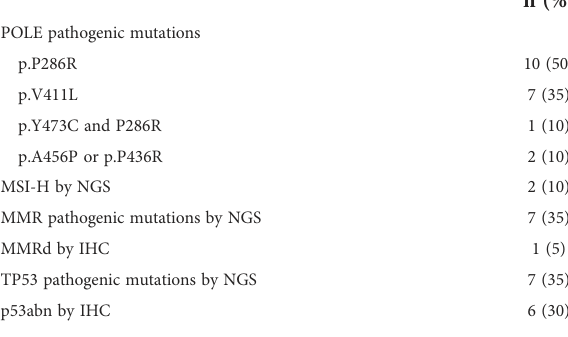
TABLE 3 Molecular characteristics of POLE-ultramutated G3 EECs.